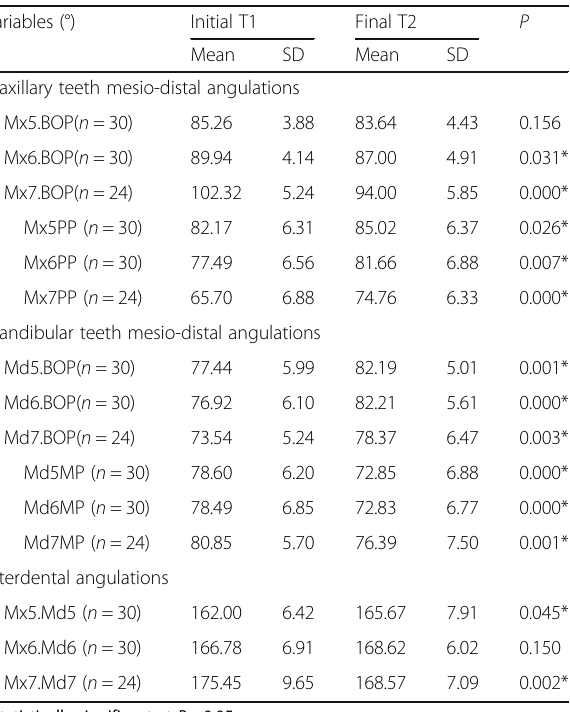
Table 2 Comparison of cephalometric variables between pretreatment and posttreatment stages for the non-extraction group (dependent t tests)